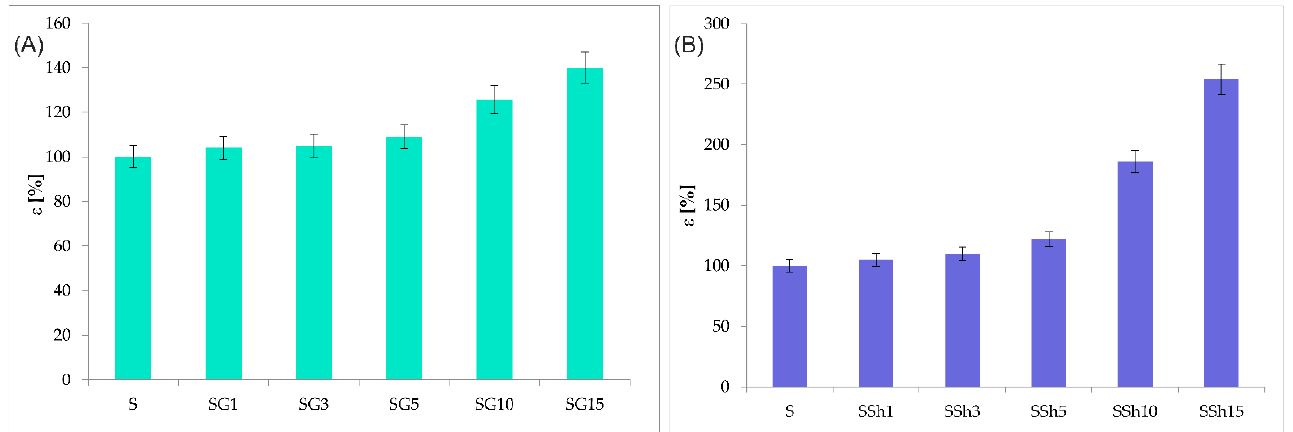
Figure 13. Elongation at break of pure PDMS (S) and its composites with an addition of ( A ) graphite and ( B )